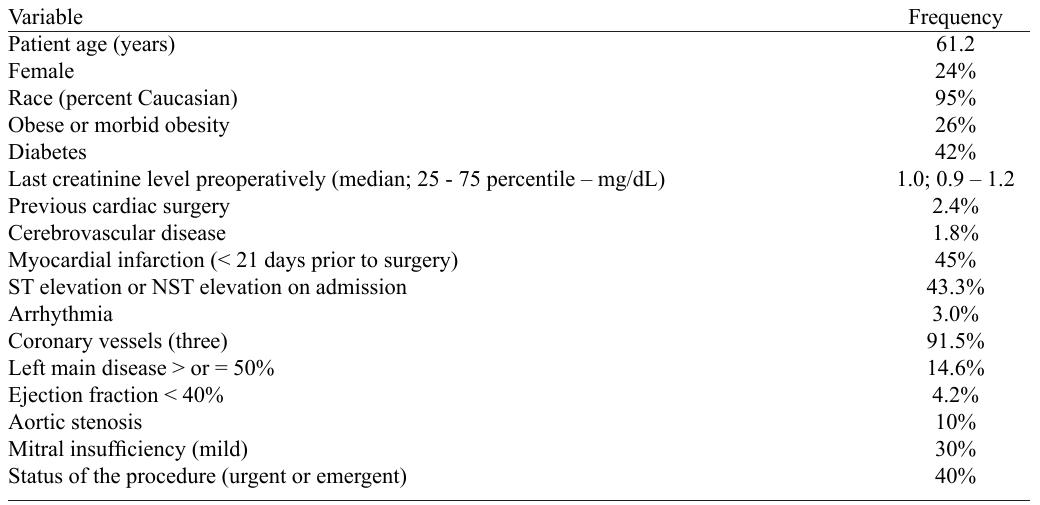
Table 1. Baseline demographic and clinical characteristics of the studied population submitted to CABG procedures (659 patients) at TotalCor Hospital, between January, 2010 and December, 2011.